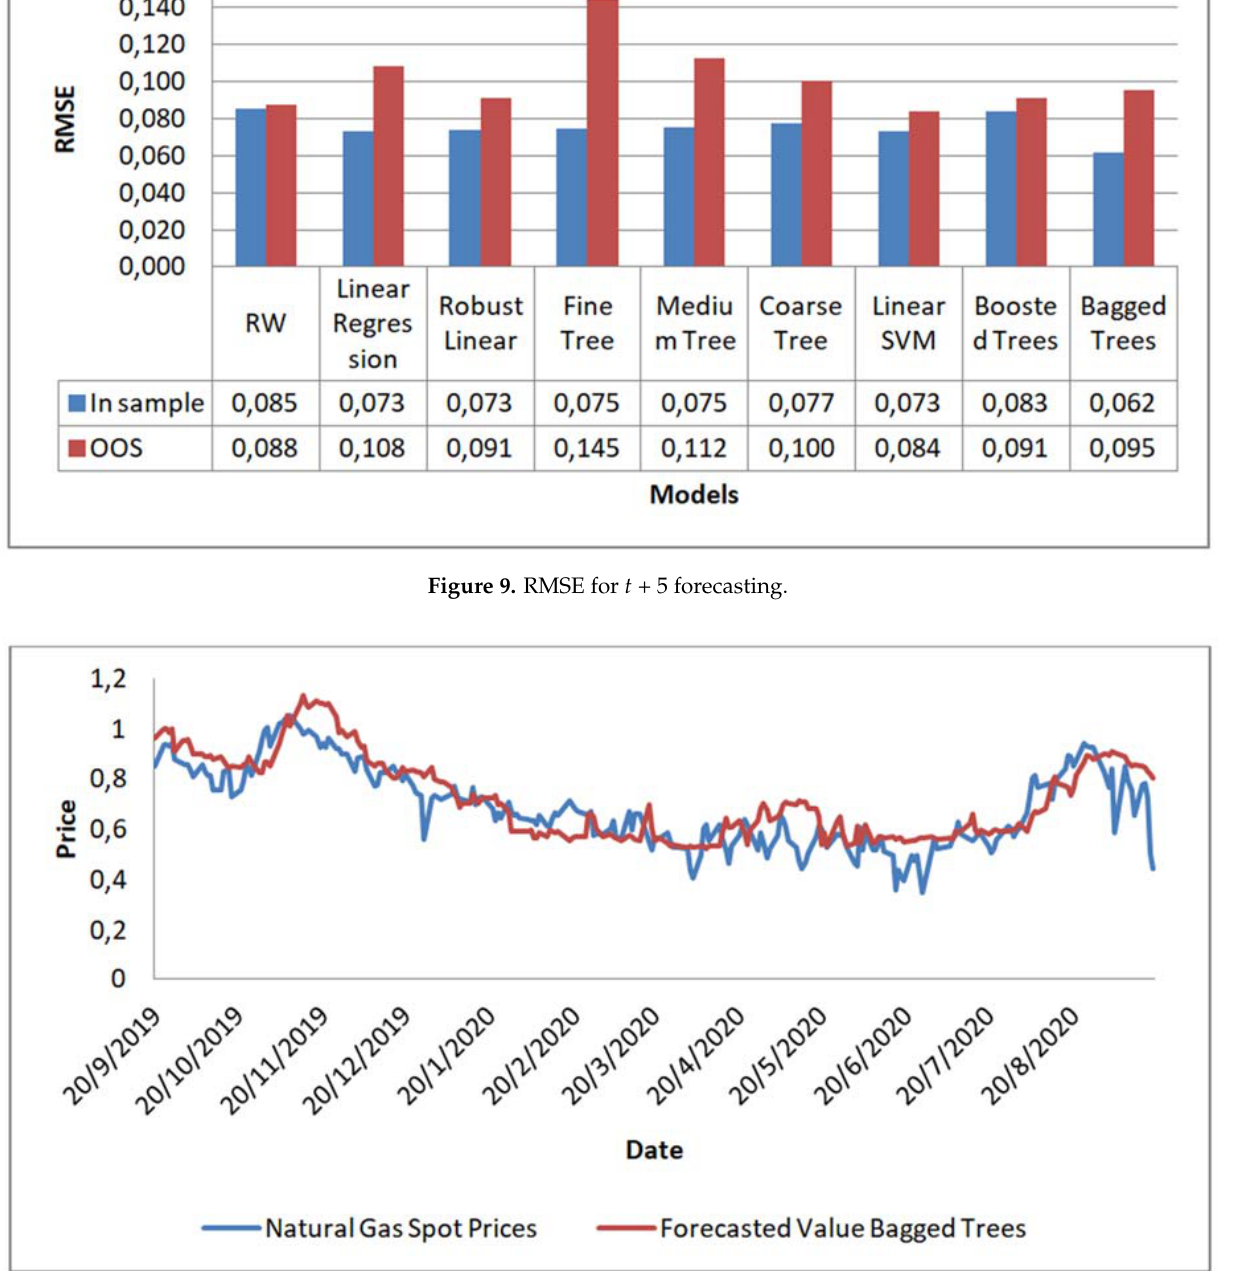
Figure 10. Comparison of the actual natural gas spot prices and the predicted prices with the bagged trees model for t + 5 in the out-of-sample part of the